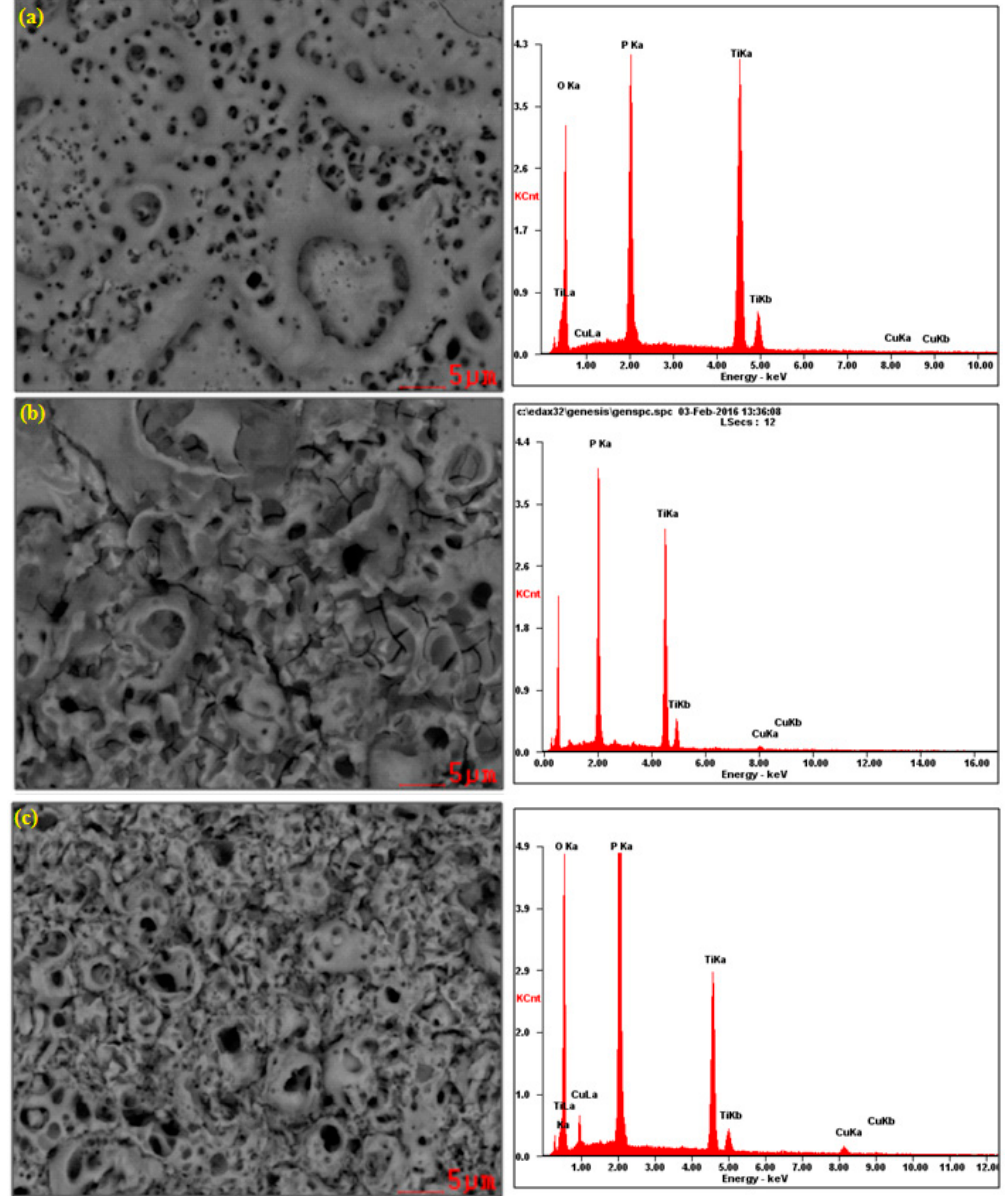
Figure 1. SEM and EDS results of titanium surface after PEO at a voltage of 450 V in the electrolyte consisting of 1 L H 3 PO 4 with: ( a ) 10 g/L; ( b ) 300 g/L; ( c ) 600 g/L Cu(NO 3 ) 2 . Table 1. Descriptive statistics of the amount of copper in the surface layer formed on titanium after PEO. weight percent atomic percent Descriptive Statistics